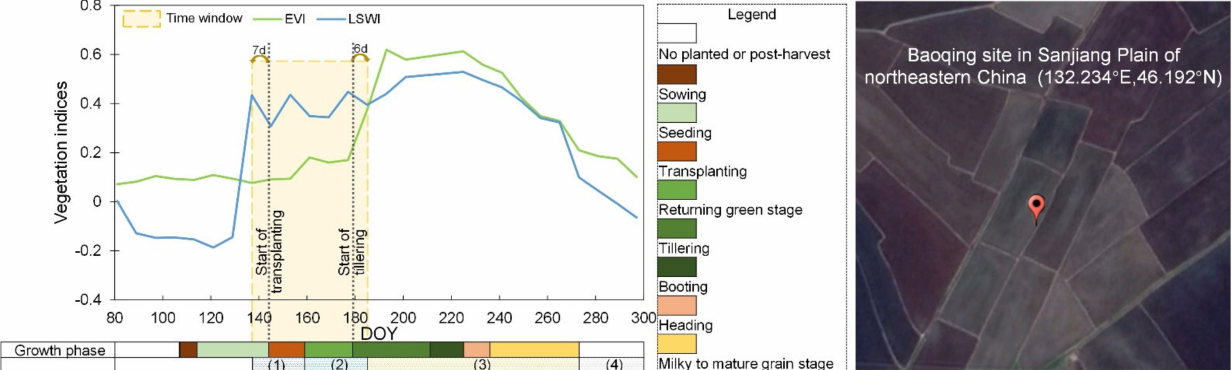
Figure 1. The relationship between site observation-based critical phenological stages of paddy rice and remote sensed flooding signals of rice paddies. The left figure shows the seasonal dynamics of the Enhanced Vegetation Index (EVI) and Land Surface Water Index (LSWI) of rice paddies (132.234 ◦ E, 46.192 ◦ N) near one agricultural meteorological site (Baoqing site) in Sanjiang Plain, northeastern China, which were obtained from MOD09A1. In the left figure, the brown arrows mean the difference between the site-observed transplanting and tillering periods and the start and end of the flooding signal retrieved from the MOD09A1 data: (1) flooding phase; (2) flooded/open-canopy phase; (3) closed canopy phase; and (4) post-harvest phase. The right image shows a corresponding landscape for a rice paddy point from Google Earth in 2011.